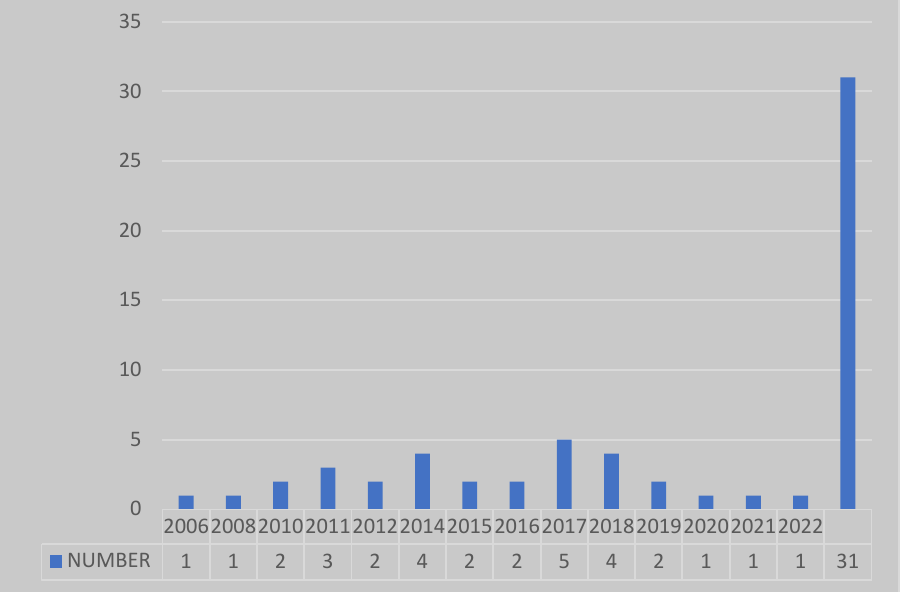
Figure 3. Publications per year (Wos and Scopus).